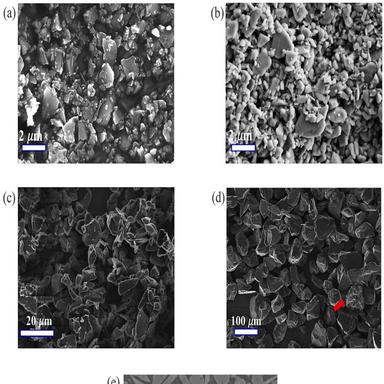
SEM and CT micrographs of the powders in the as-received state: (a) fine; (b) rounded; (c) intermediate and (d) coarse. The red arrow in (d) indicates a particle with rough surface. (e): A slice of μCT images on the coarse powder with the red arrows showing the particles with initial defects. (For interpretation of the references to colour in this figure legend, the reader is referred to the web version of this article.)